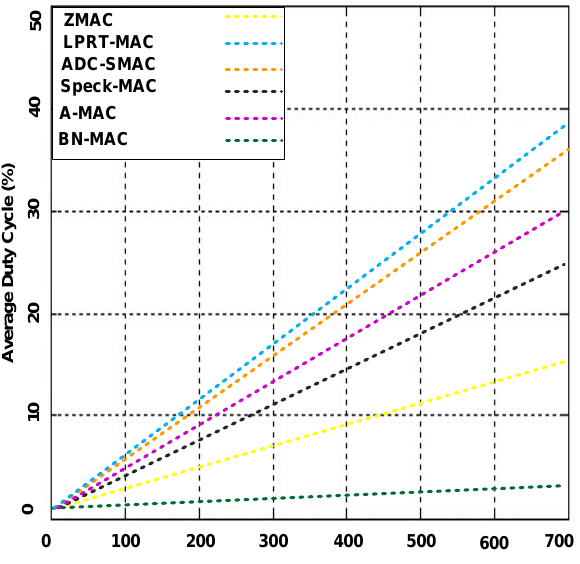
Figure 21. Average duty cycles at variable sensing